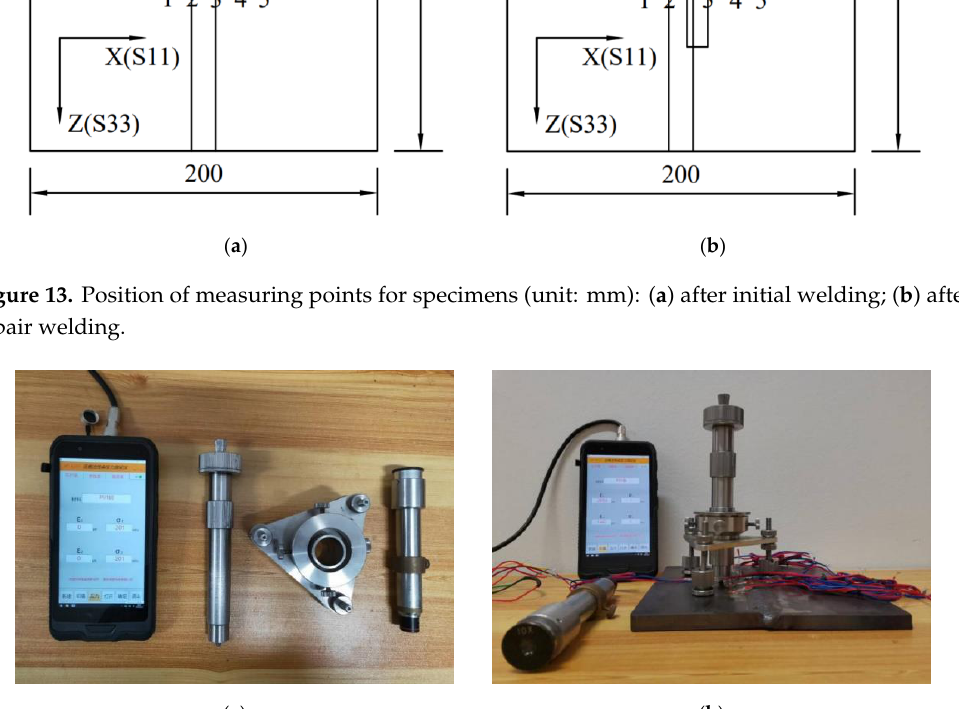
Figure 14. The measurement of residual stress: ( a ) residual stress measurement system; ( b ) residual stress on-site measuring.